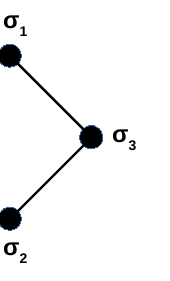
Figure 2 . Two basic con(cid:12)gurations of three Ising